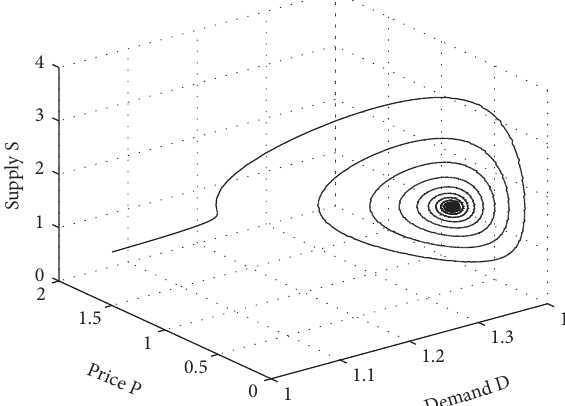
Figure 4: The phase diagram of the global asymptotic stability at E in